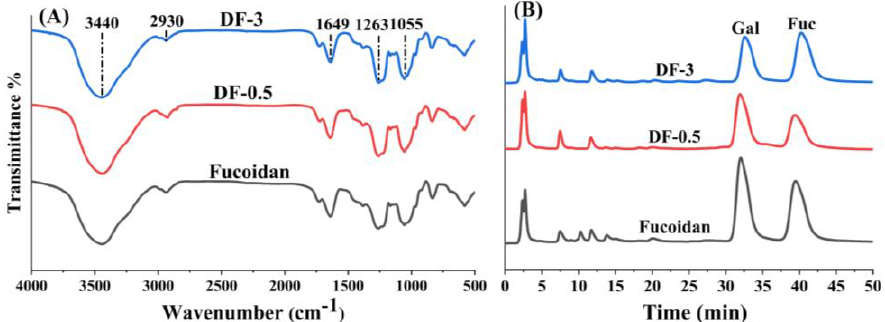
Figure 2. FT-IR spectra of freeze-dried samples ( A ) and HPLC chromatograms of the component monosaccharides ( B ) of fucoidan and its 2 degradation products (DF-0.5 and DF-3).